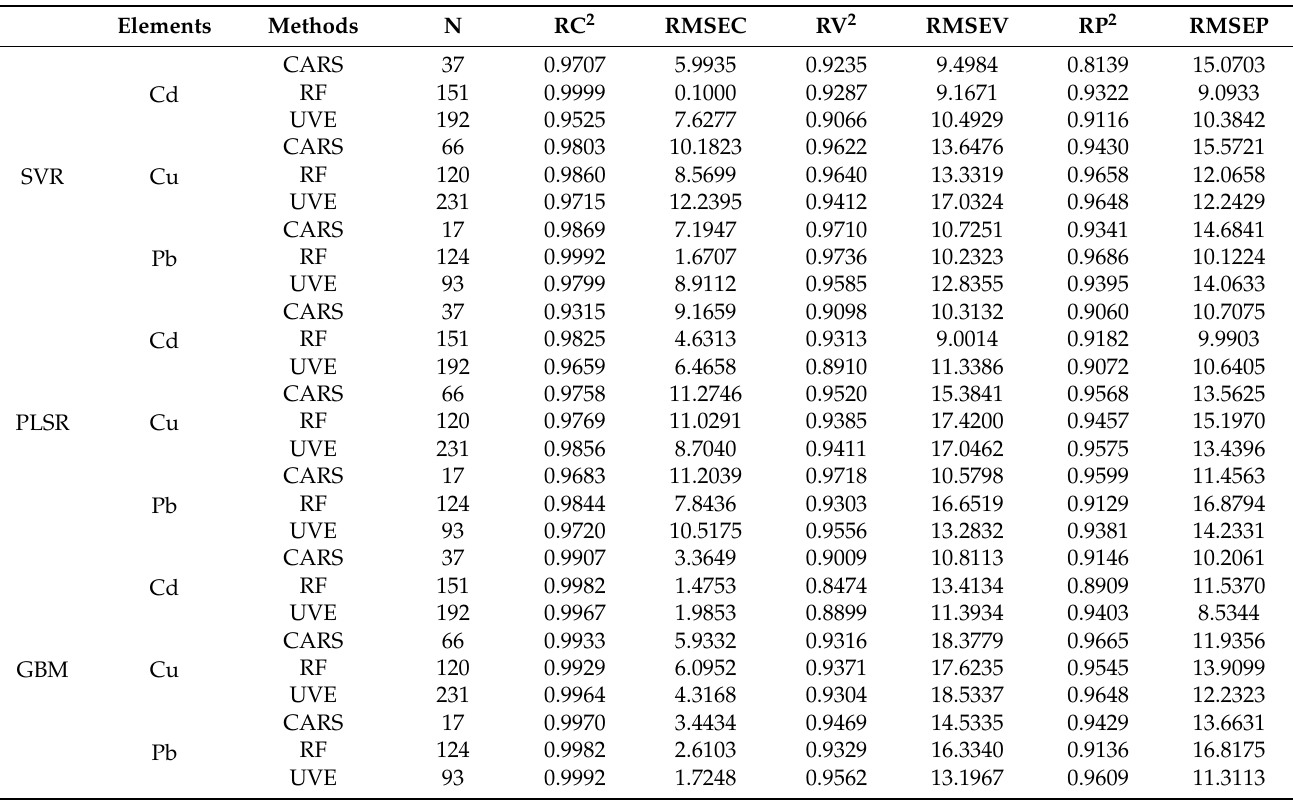
Table 3. Prediction results of the different models using three variable selection (CARS, RF and UVE)